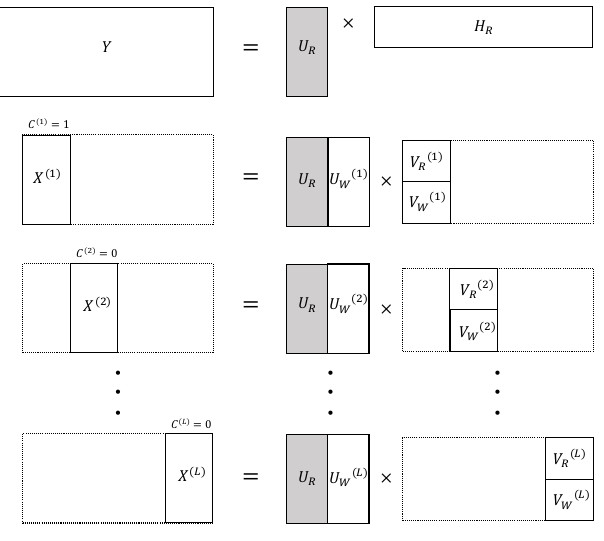
Figure 3. Pictorial illustration of the matrix decomposition based on